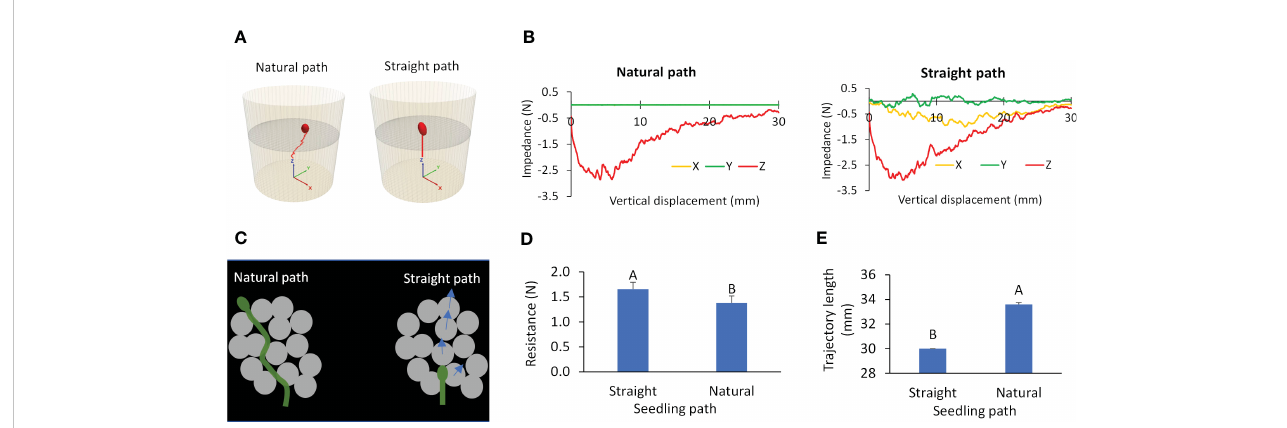
FIGURE 10 Simulated paths and resistances for two scenarios: natural path and straight path. (A) Trajectory. (B) Resistances to cotyledon. (C) Illustration of a growing seedling in growth medium. (D, E) Average total resistance and length of trajectory respectively; values labeled with different letters are statistically different according to Duncan ’ s Multiple Range Test at P<0.05.